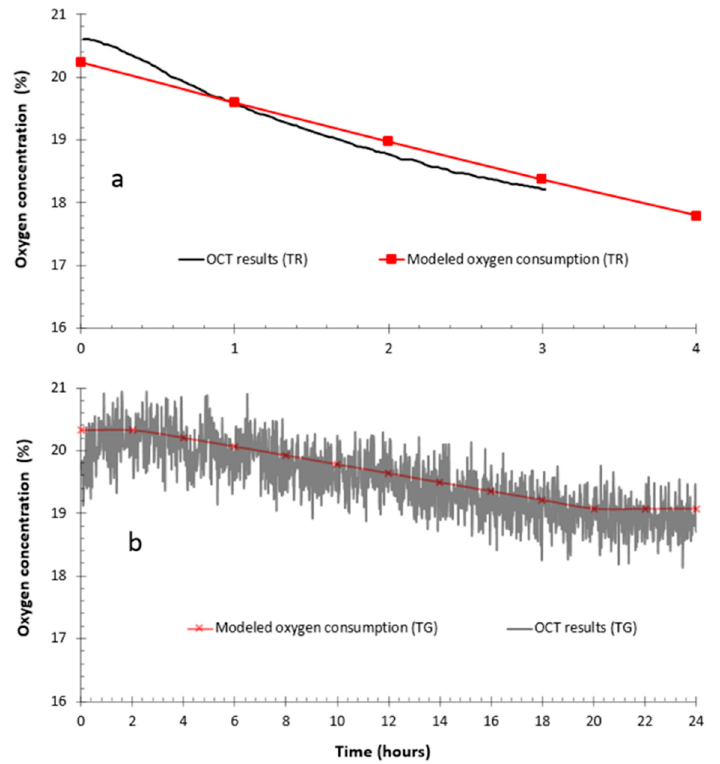
Figure 5. Temporal evolution of measured and modeled oxygen concentrations for: ( a ) the reactive tailings and ( b ) the low-sulfide tailings.